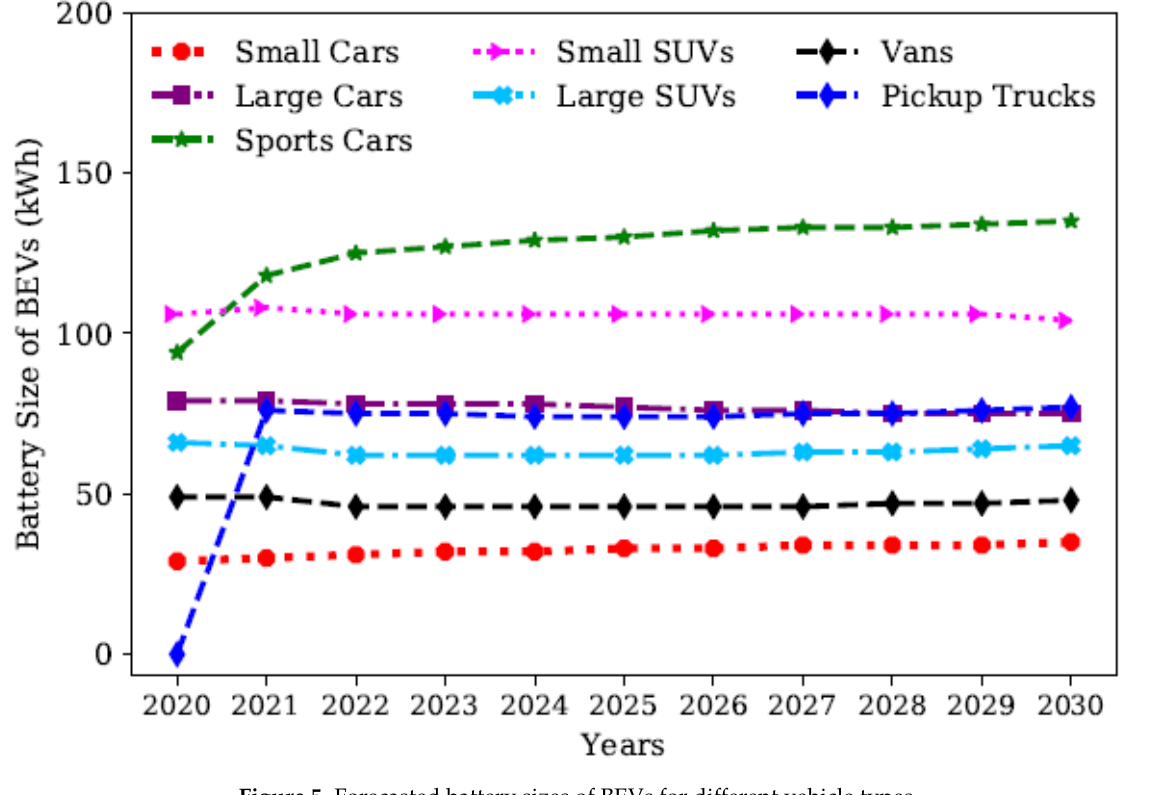
Figure 5. Forecasted battery sizes of BEVs for different vehicle types.